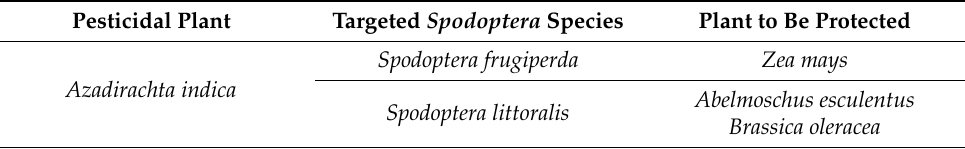
Table 6. Plant species reported in KB in relation to the Spodoptera genus and host plants to be protected. Pesticidal Plant